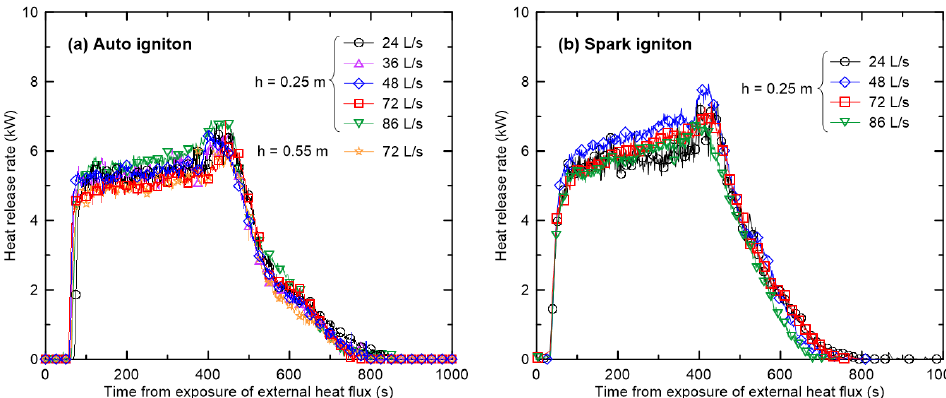
Figure 11. Time histories of heat release rate with the changes in exhaust flow rate and hood height (h) for auto and spark ignition.